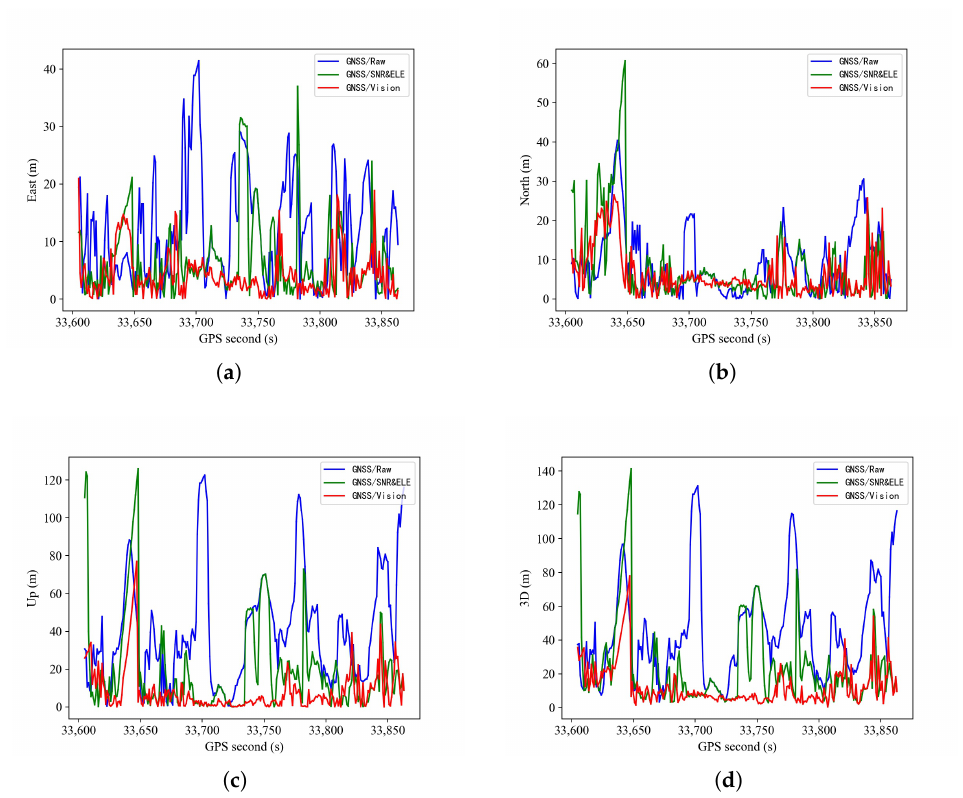
Figure 19. Positioning error. ( a ) Positioning error in the eastward orientation. ( b ) Positioning error in the northward orientation. ( c ) Positioning error in the upward orientation. ( d ) 3D positioning error.